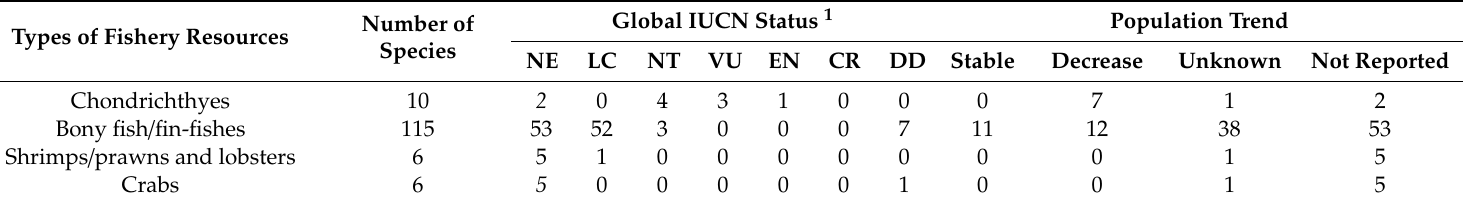
Table A2. The available fishery species recorded in the study areas in the coastal ecosystems of the south-eastern coast of Bangladesh. Types of Fishery Resources